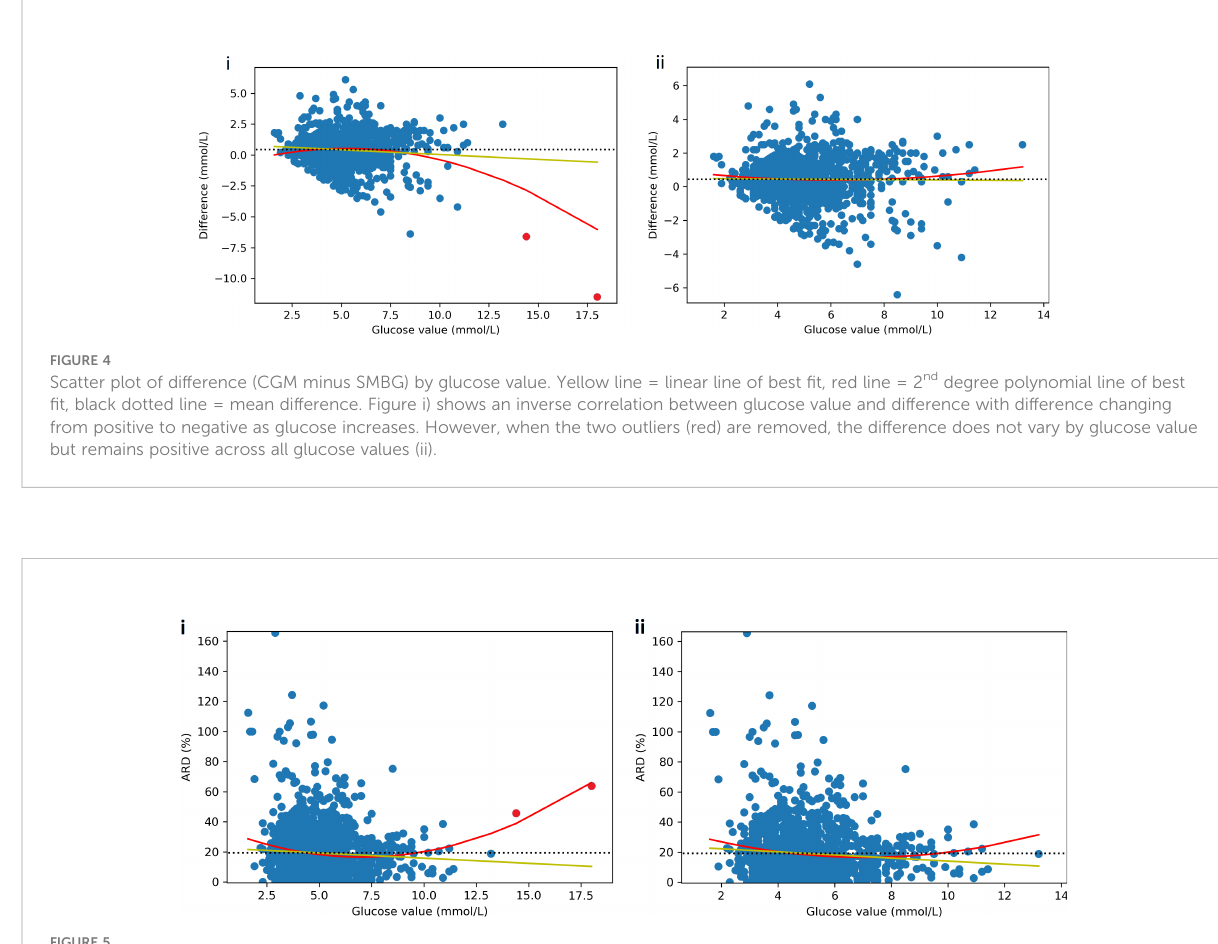
FIGURE 5 Scatter plot of absolute relative difference (ARD) between CGM and SMBG by glucose value. Yellow line = linear line of best fi t, red line = 2 nd degree polynomial line of best fi t, black dotted line = mean absolute relative difference (MARD). Figure i) shows a linear negative correlation between glucose value and ARD with ARD decreasing as glucose increases. However, the 2 nd degree polynomial shows a U shaped curve with the greatest accuracy in the normal glucose range from 5-9mmol/L. When the two hyperglycaemia outliers (red) are removed, the relationships are not signi fi cantly altered